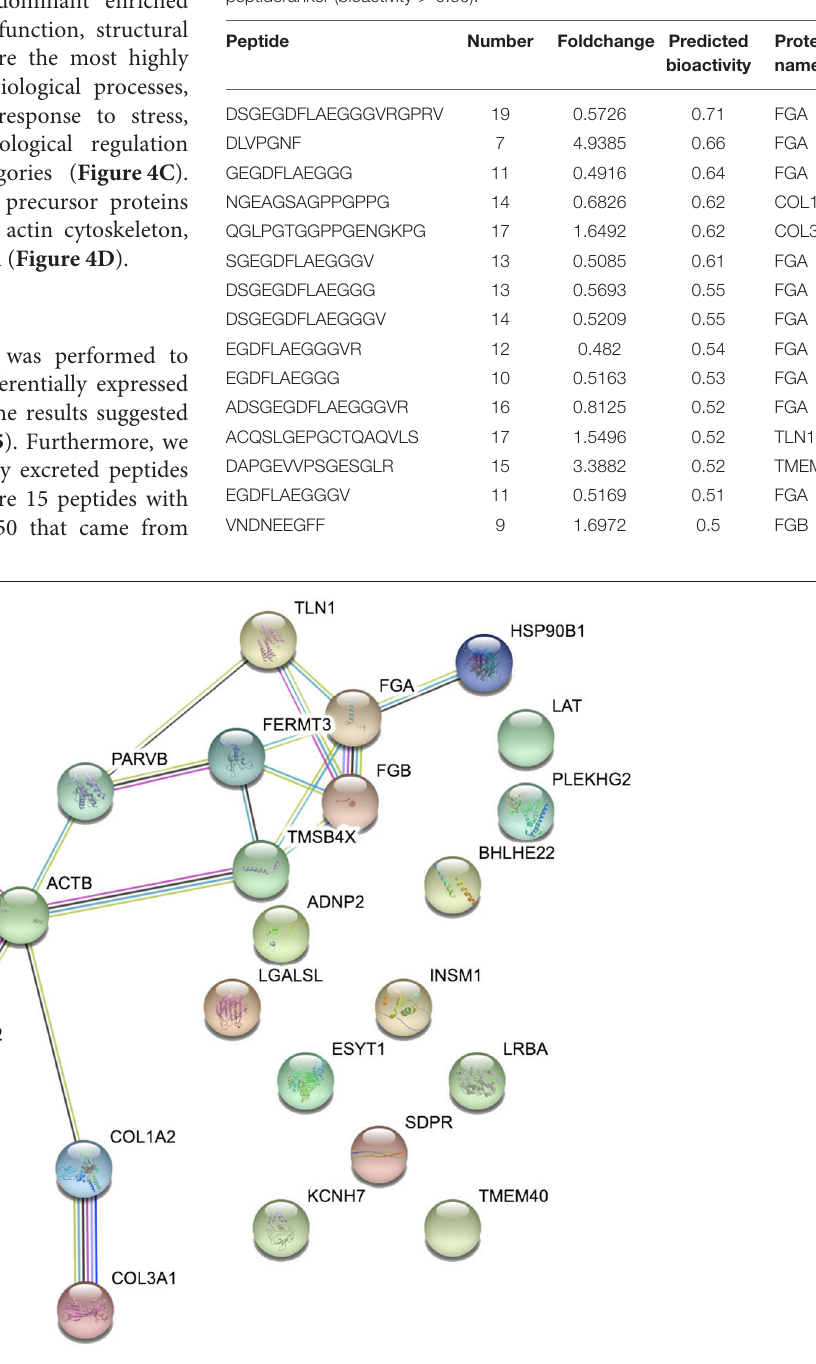
Frontiers in Pediatrics |